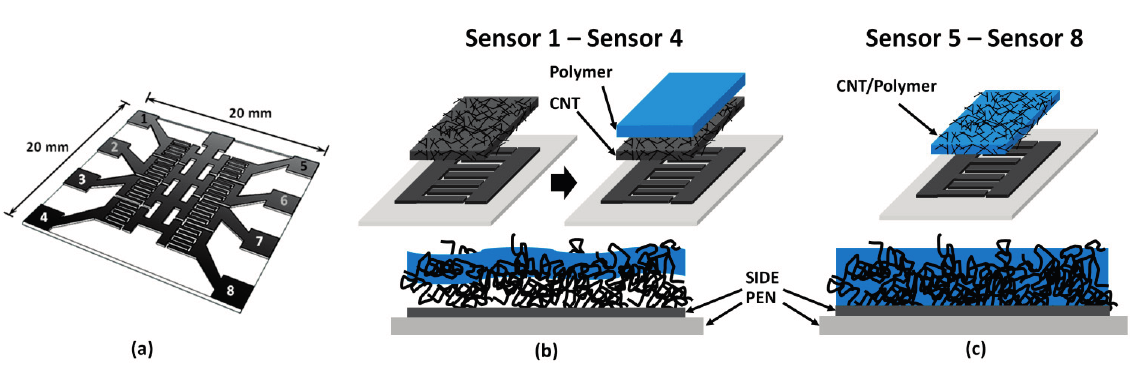
Figure 1. Architectures of ( a ) the silver interdigitated electrode (SIDE); ( b ) the double printed layers (DPLs) sensor and ( c ) the blended single layer (BSL)